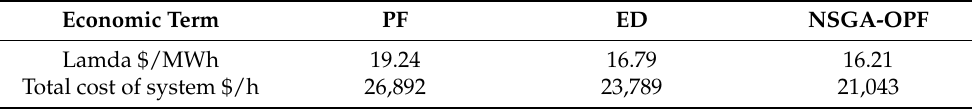
Table 3. Economic Indicators among different scenarios.